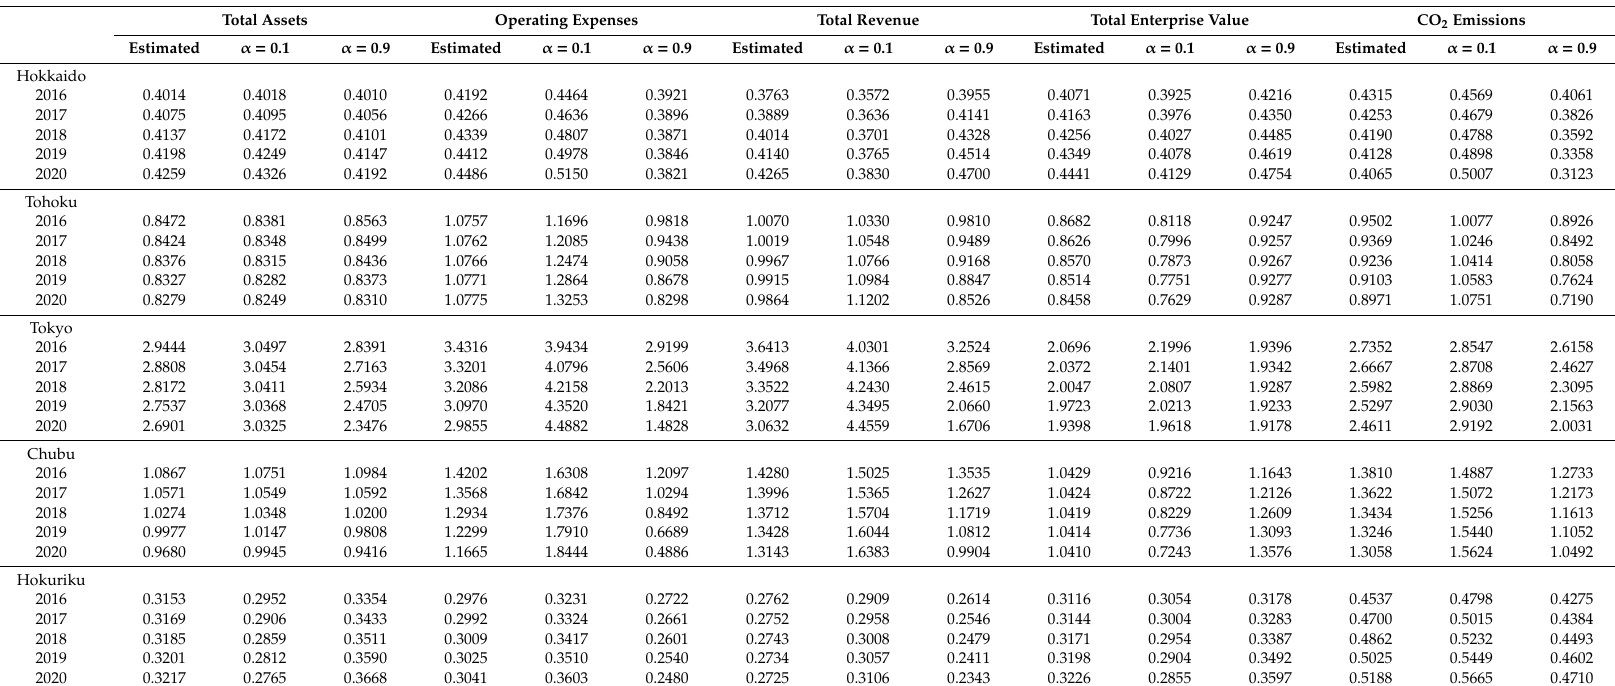
Table 7. Forecasted Measures of Electric Power Companies